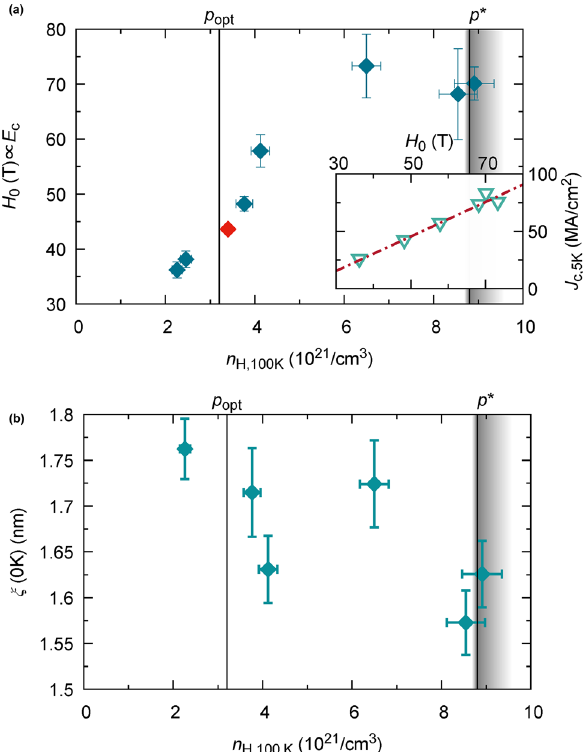
Figure 5. Charge carrier density dependence of superconducting parameters: ( a ) Characteristic magnetic field, H 0 , versus charge carrier density at 100 K. H 0 is obtained by electrical measurements of the vortex glass transition line. It provides a measure of the pinning energy and thus is closely linked to the superconducting condensation energy, E c . The red diamond is reproduced from 23 (280 nm, PLD), falling on the same line as our results. Inset shows J c ( 5K ) versus H 0 , revealing a linear relation between these independently measured quantities. This emphasizes the strong correlation of the critical current density and the condensation energy. Dashed line is a guide to the eye. ( b ) Superconducting coherence length ξ( 0 ) as a function of Hall number at 100 K. ξ( 0 ) is obtained by electrical measurements of H c2 , determined from flux flow resistivity analysis up to 9 T (SI-Fig. 5b). A weak decrease with increasing charge carrier doping is observed, which alone cannot account for the strongly enhanced J c in the overdoped region. y-error bars correspond to uncertainties from the underlying fit